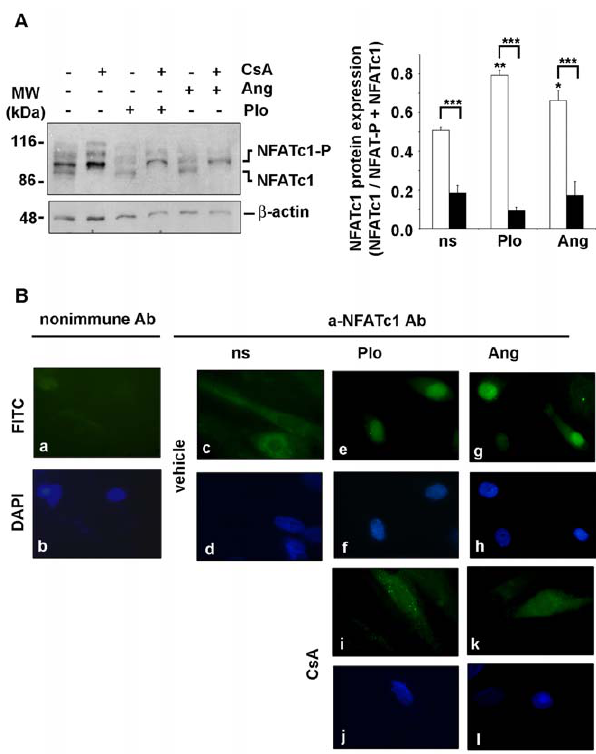
Figure 3. NFAT dephosphorylation and nuclear localization was abrogated by CN inhibition in primary rat ESC. (A) Immunoblots of whole extracts of primary cultured ESC isolated from uteri of non-pregnant rats showing endogenous expression of NFATc1 and b -actin as loading control. Primary cultures of cells isolated from uteri of non-pregnant rats were pretreated for 1 h with vehicle (lanes 1,3, 5) or 200 ng/ml of CsA (2, 4, 6), and then exposed for 2 h to PIo (lanes 3 and 4); 500 nM of Ang II (lanes 5 and 6), or were left unstimulated (ns, lanes 1 and 2). The position of phosphorylated NFAT (P-NFATc1) and dephosphorylated NFATc1 (NFATc1) is indicated. Right panel bar plot shows the densitometric data analysis of the results shown in the left panel. The NFAT/ b -actin ratio was calculated and then the NFATc1/(NFATc1 + NFATc1-P) ratio was plotted. The values are the means 6 SD obtained from three independent experiments performed. Open bars, cells pre-treated with vehicle; closed black bars, cells pre- treated with CsA ** P , 0.01; * P , 0.05 (ANOVA). (B) Immunofluores- cence analysis of endogenous NFAT protein with anti-NFATc1 antibody (c–l) or nonimmune Ab (a and b) as control of unspecific staining. Primary cultures of cells isolated from non-pregnant rats were pretreated for 1 h as before with vehicle (c–h) or CsA (i–l), and then exposed 2 h to PIo (e–f, i–j); 500 nM of Ang II (Ang, g–h, k–l), or were left unstimulated (ns, c–d). (a, c, e, g, i, k): FITC staining of the cells. (b, d, f, h, j, l): nuclei staining with DAPI. Magnification 200 6 . Shown is a representative experiment out of three performed.